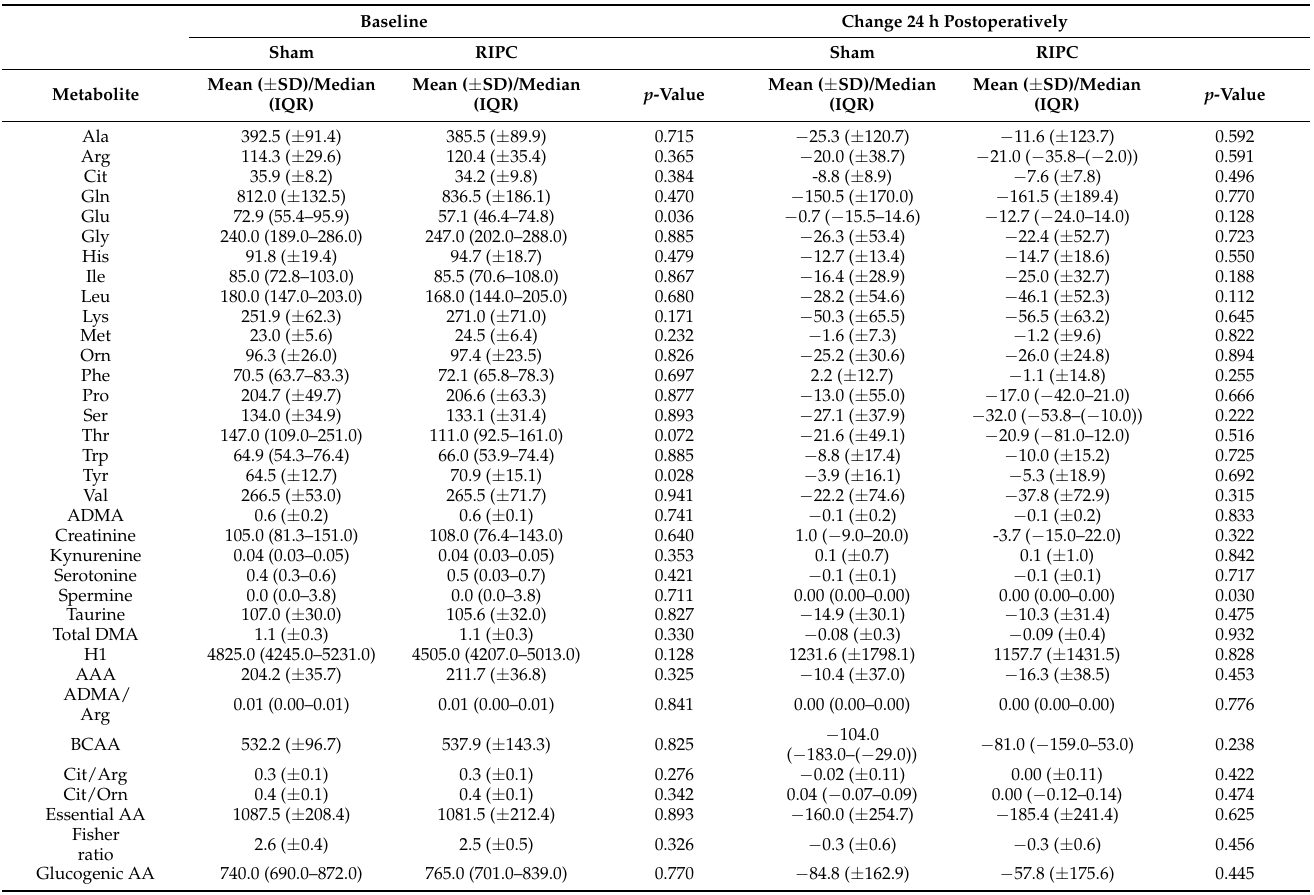
Table 3. Comparison of baseline levels and changes in the metabolites 24 h after operation between the RIPC and sham